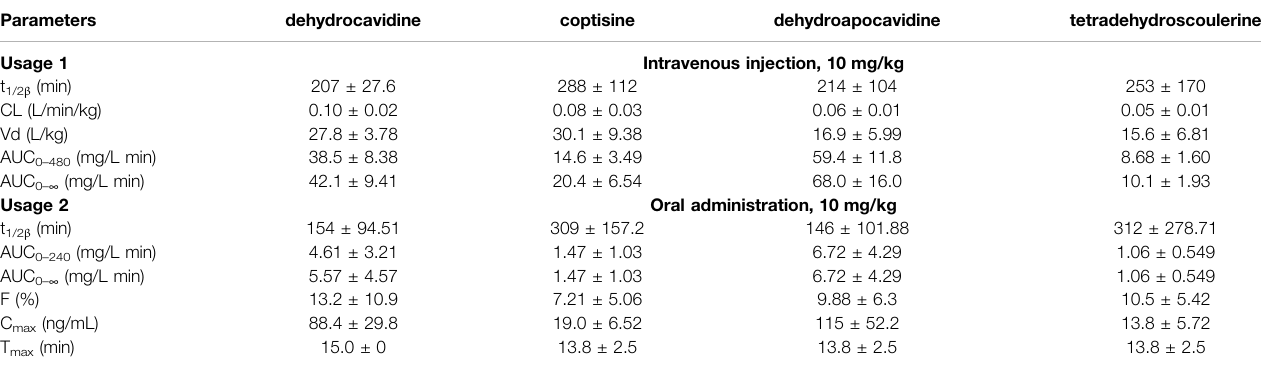
TABLE 2 | The pharmacokinetic parameters of the four components isolated from CSB in rats.